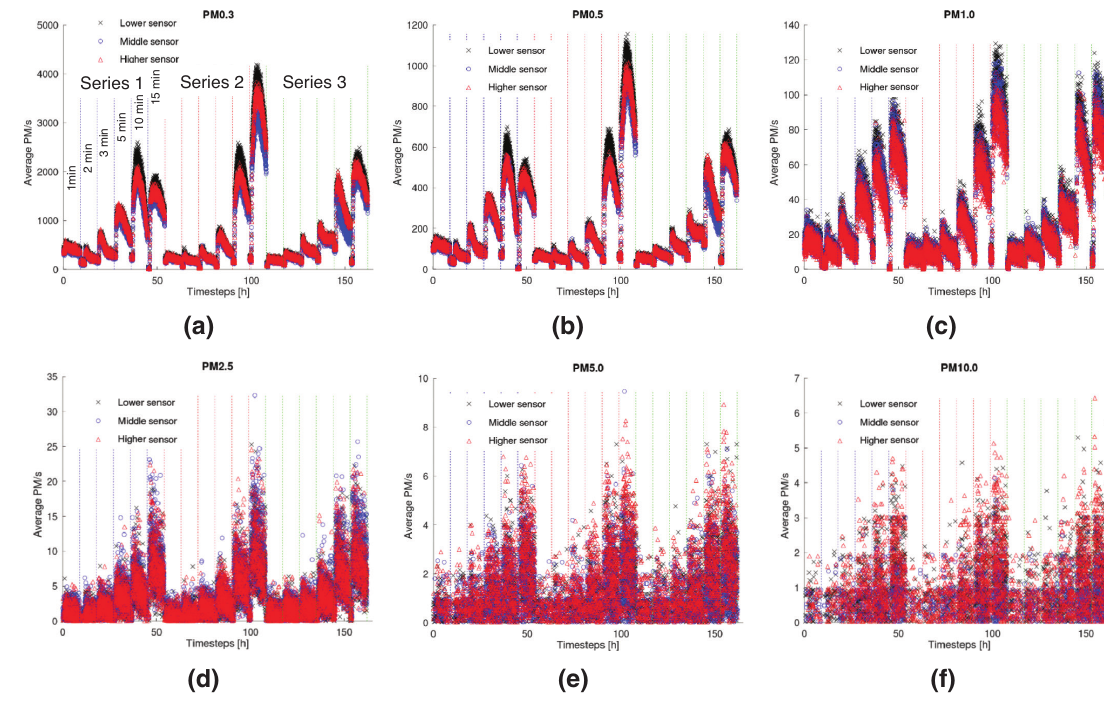
Particle counts for (a) PM0.3, (b) PM0.5, (c) PM1.0, (d) PM2.5, (e) PM5.0 and (f) PM10. Different segments in each plot delineated in different colours indicate three repeated sets of each test. The findings are indicated for 1, 2, 3, 5, 10 and 15 min of blowing and for each of the three series as shown in (a). (Source: Authors,